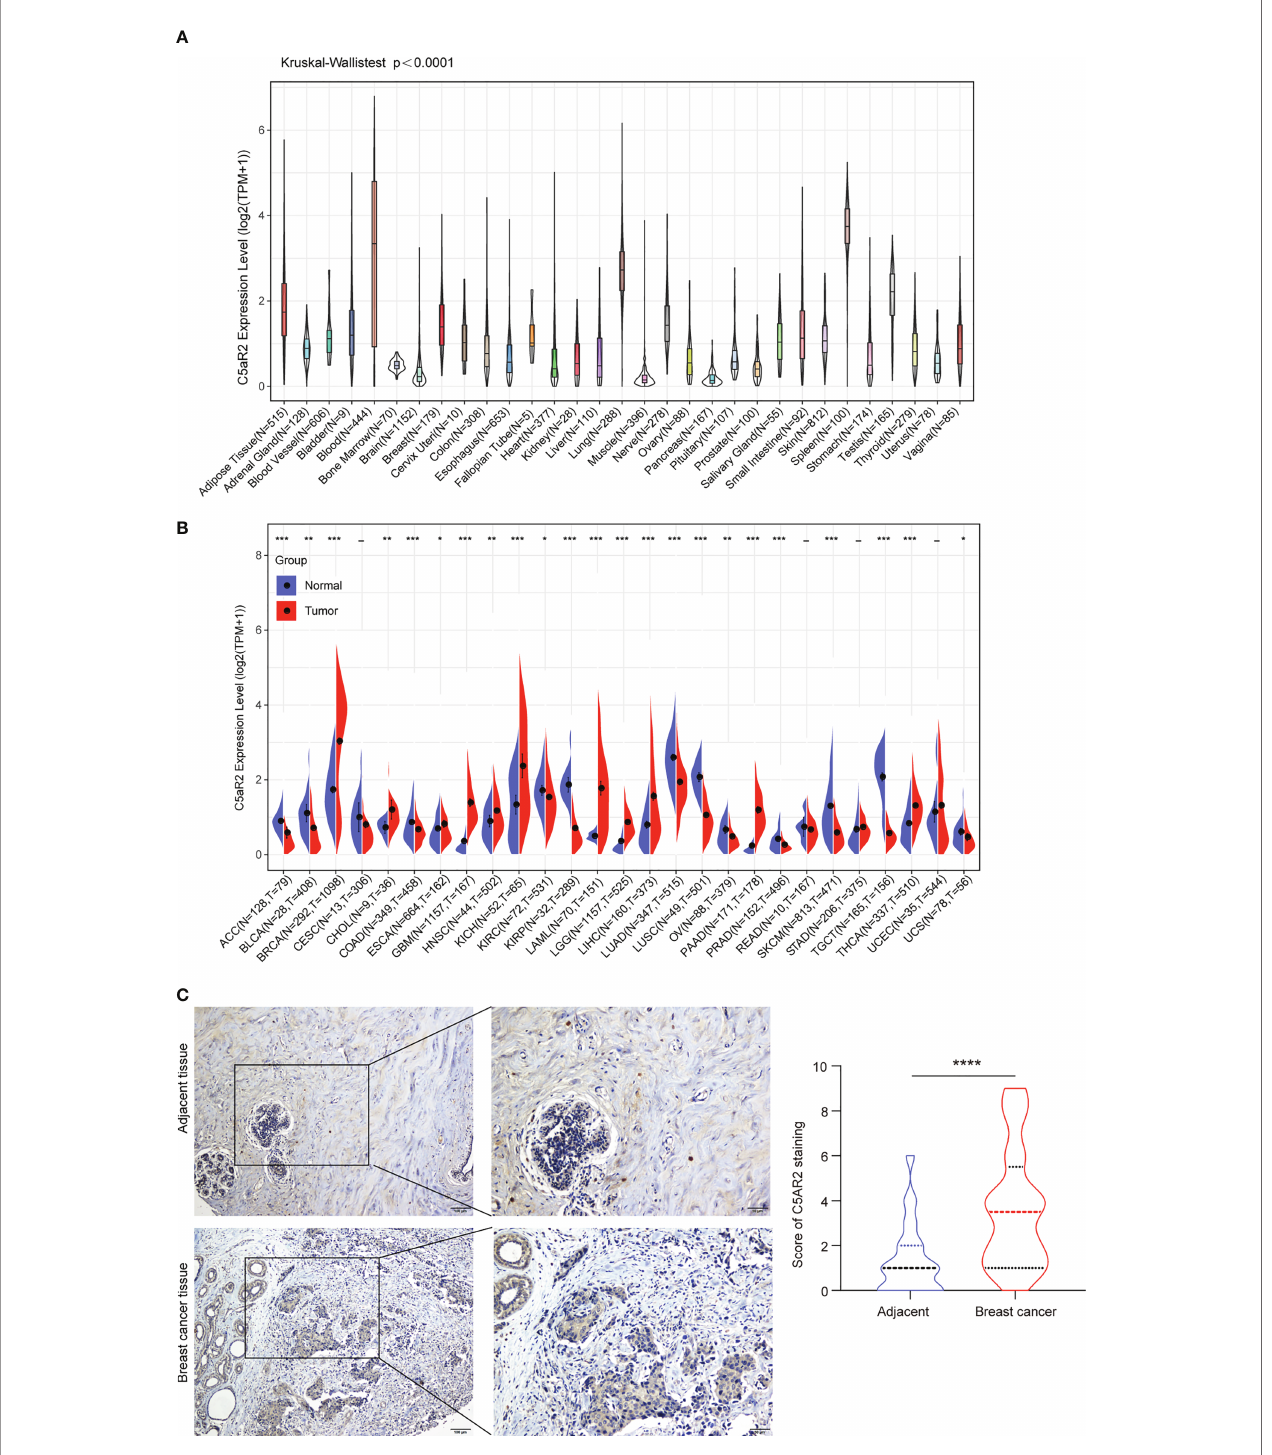
FIGURE 1 | The expression levels of C5AR2 between cancerous and normal tissue samples. (A) C5AR2 expression in normal tissues. (B) The contrasts of C5AR2 expression between cancerous and noncancerous tissues from TCGA and GTEx data. (C) The representative images of C5AR2 staining in breast cancer and adjacent tissues. The protein expression levels of C5AR2 were detected by IHC staining in 45 paired breast cancer and adjacent tissues. Scale bar: 100 µm (left panel) or 50 µm (right panel). The quantitative results were shown in the right. *P < 0.05, **P < 0.01, ***P < 0.001, and ****P <